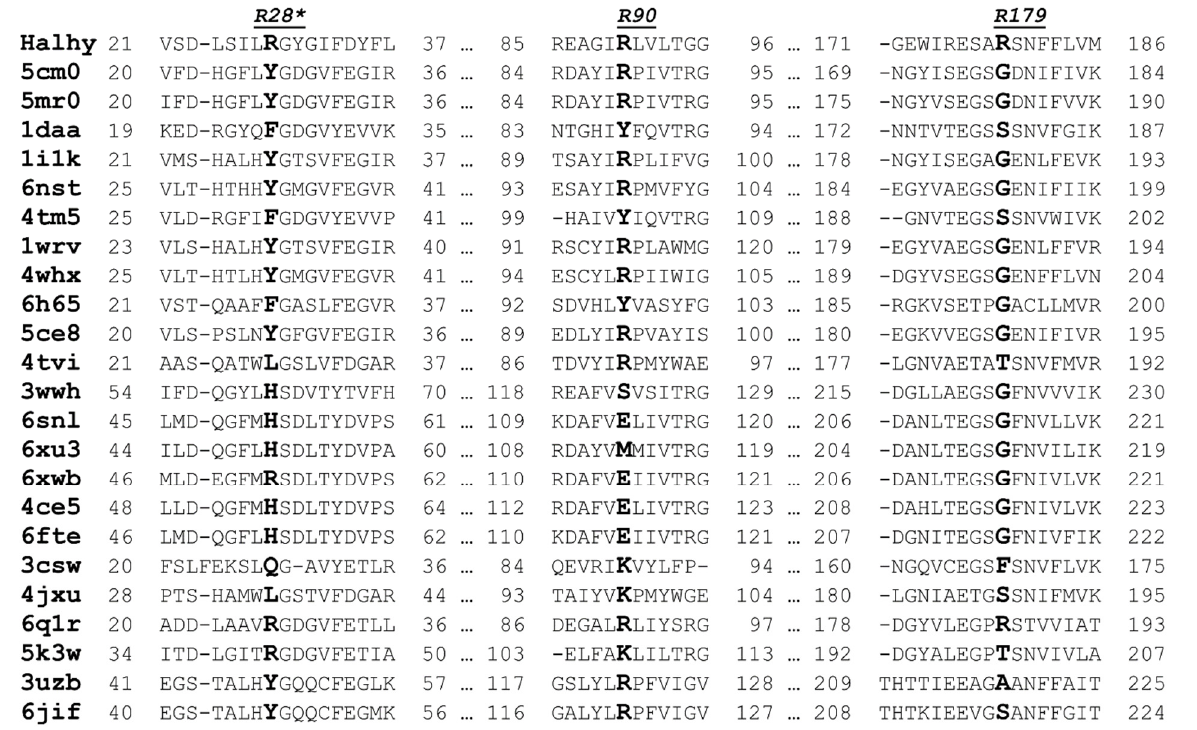
Figure A1. The multiple structure alignment of Halhy and its close structural homologs (RMSD between C α 1.4-2.0 Å) referred to by the PDB codes. The amino acid residues in the equivalent positions of R28*, R90, and R179 (numbering corresponds to Halhy) are marked in bold.